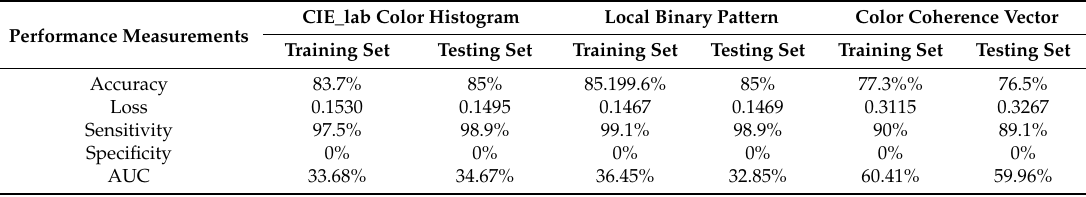
Table 5. Simulation results for the use of multilayer perceptrons in WCE image ulcer detection. Performance